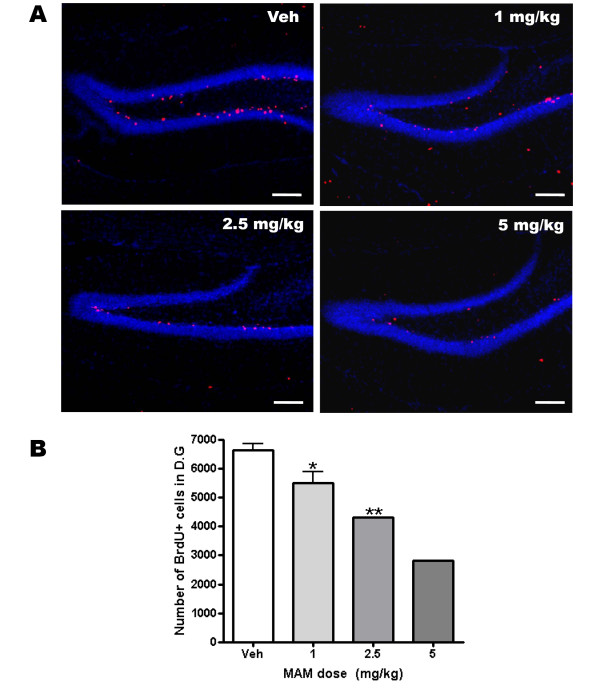
MAM treatments reduced hippocampal neurogenesis but did not affect gross morphology. (A) Representative images show the dentate gyrus of mice that were injected with MAM for 2 weeks. Doses of MAM are indicated in each image. Cells were labeled with BrdU (red) and DAPI (blue). Upper left: vehicle (Veh). Upper right: 1 mg/kg. Lower left: 2.5 mg/kg. Lower right: 5 mg/kg. Scale bar, 100 μm. (B) Total number of BrdU+ cells in dentate gyrus. Three mice were used for analysis. Note that two of the three mice died during 5 mg/kg MAM injection. *, p < 0.05; **, p < 0.01 compared with vehicle. Dentate gyrus (D.G).